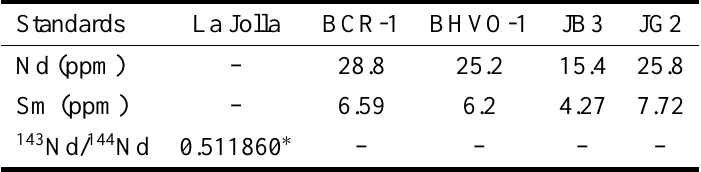
Recommended values for the used standards (Govindaraju 1994) Standards